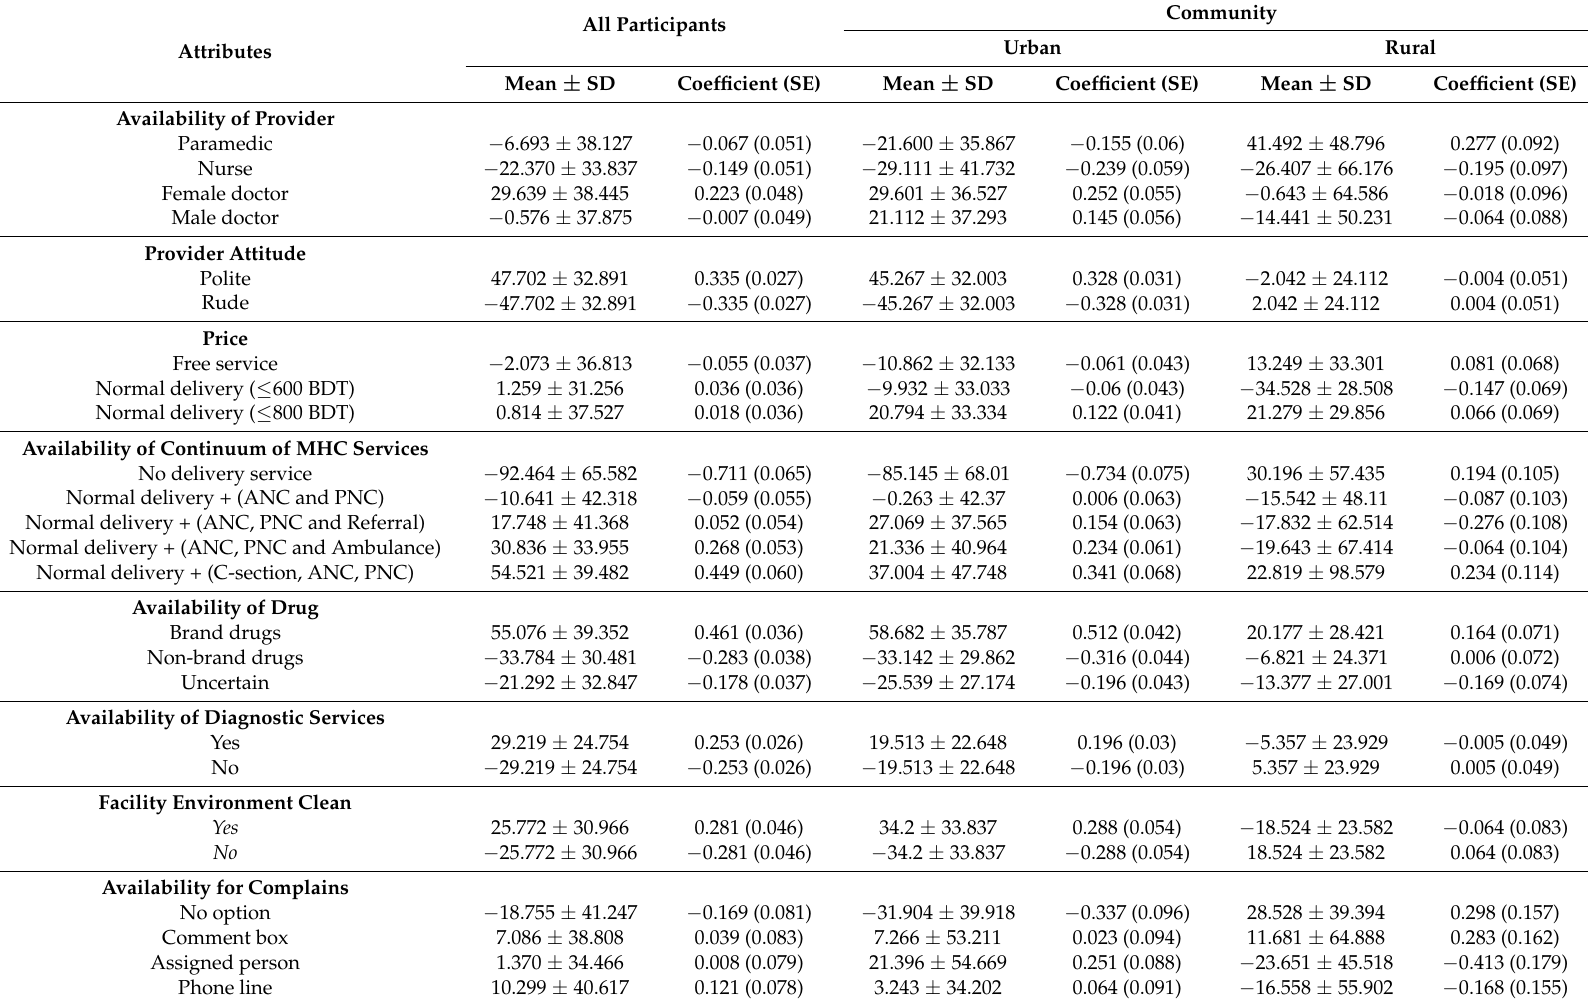
Table 3. The distribution of average scores 1 and factors influencing 2 maternal health